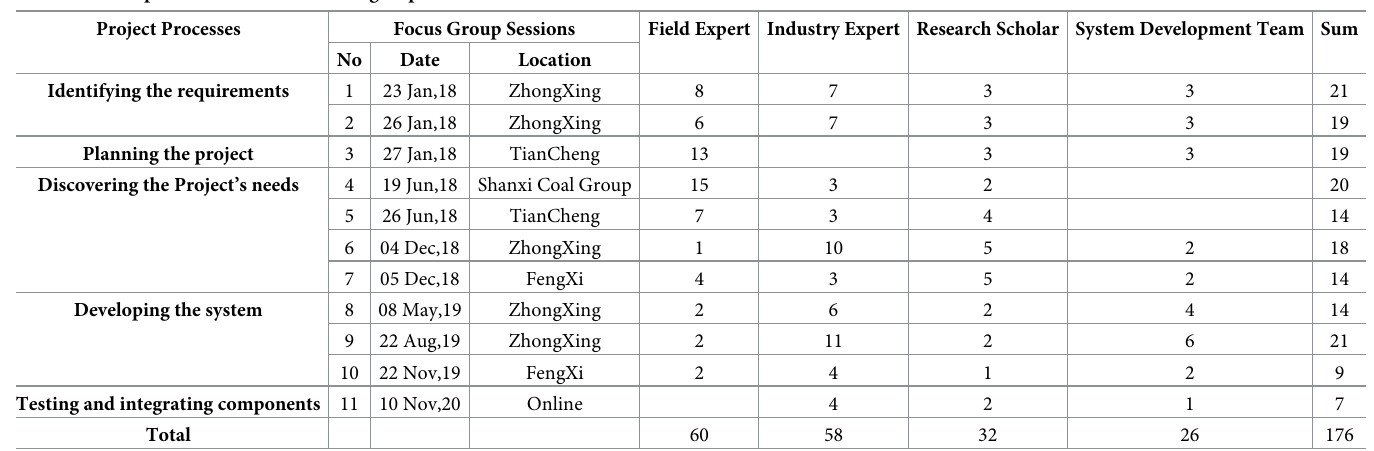
Table 1. Descriptive information on focus group studies.